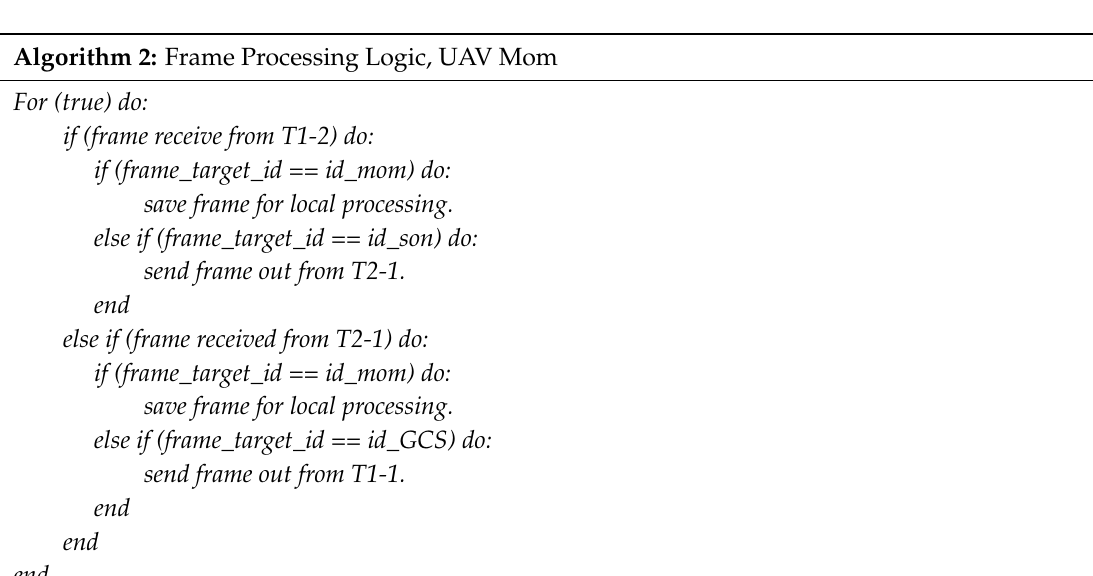
Algorithm 2: Frame Processing Logic, UAV